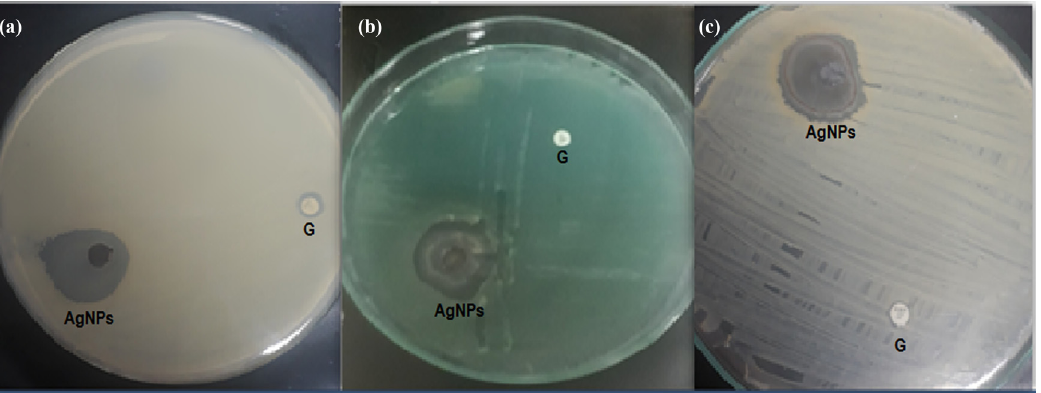
Figure 6: Antimicrobial activity of AgNPs and gentamycin ( G ) on ( a ) C. albicans , ( b ) P. aeruginosa , and ( c ) methicilne - resistant S. aureus .